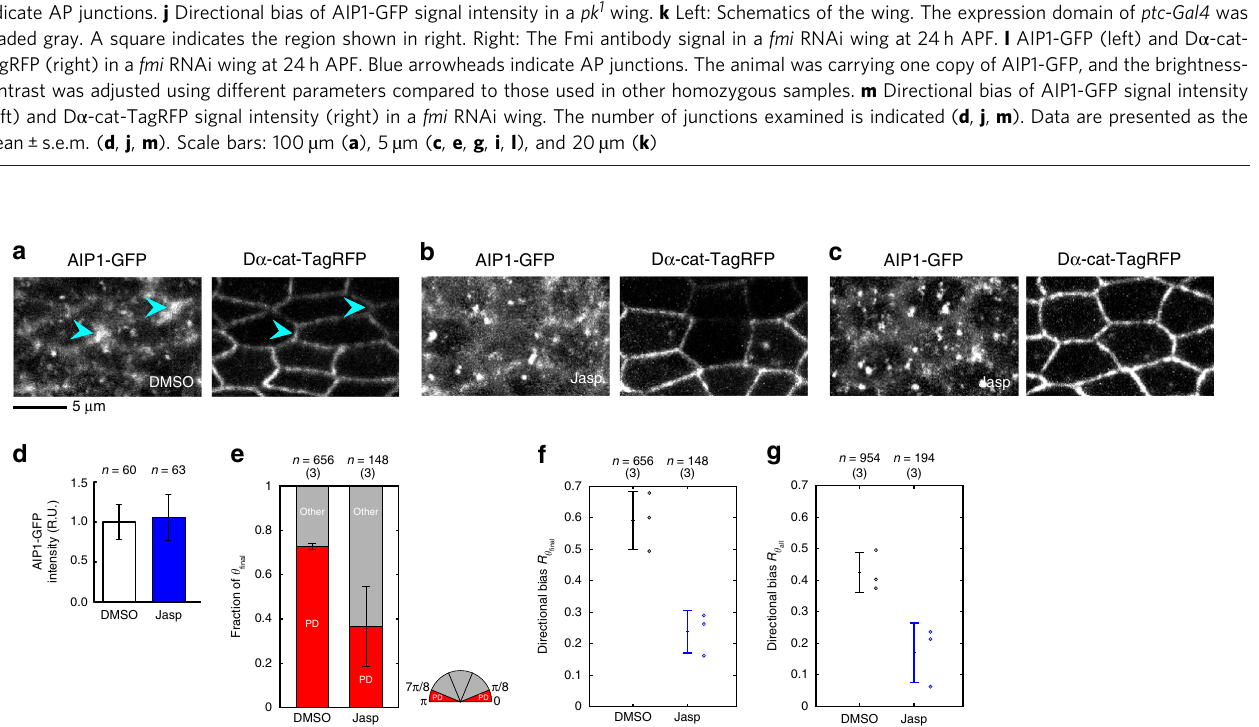
Fig. 4 Jasp treatment results in disoriented cell rearrangement. a – c AIP1-GFP (left) and D α -cat-TagRFP (right), in DMSO-treated ( a ) and Jasp-treated ( b , c ) wings at 24 h APF. Images in panels b , c show different regions of the same wing. Cells showing a faint signal of D α -cat-TagRFP in b were located near the boundary of the ptc-Gal4 expressing region. Blue arrowheads indicate AP junctions. d The average signal intensity of AIP1-GFP along junctions in DMSO- and Jasp-treated wings. Welch ’ s t -test: DMSO vs. Jasp, P > 0.2. e – g Cell rearrangement defects induced by Jasp treatment were quanti fi ed as shown in Fig. 2e – h. e PD (red) and other (gray) fractions of θ fi nal . f , g R θ fi nal ( f ) and R θ all ( g ) for each condition. f Welch ’ s t -test: DMSO vs. Jasp, P < 0.01. g Welch ’ s t -test: DMSO vs. Jasp, P < 0.05. The number of junctions ( d ), and the numbers of events and pupae examined ( e – g ) are indicated. Data are presented as the mean ± s.d. ( d – g ). Scale bar: 5 µ m ( a